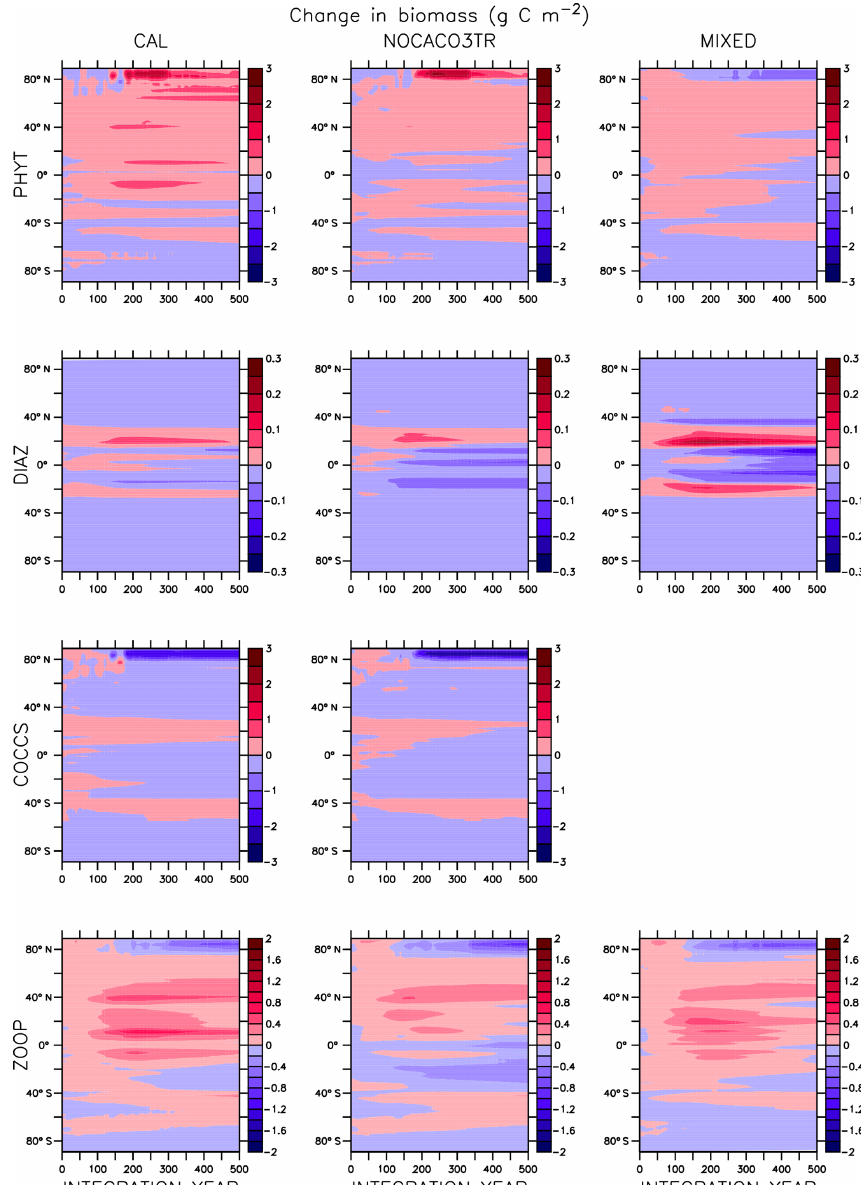
Figure A3. Zonally averaged changes in plankton biomass over the COOLING simulation.